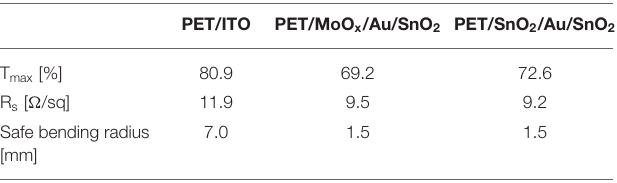
TABLE 3 | Optoelectrical and mechanical properties of commercial PET/ITO and flexible PET/dielectric/metal/dielectric electrodes optimized in this work. PET/ITO PET/MoO x /Au/SnO 2 PET/SnO 2 /Au/SnO 2